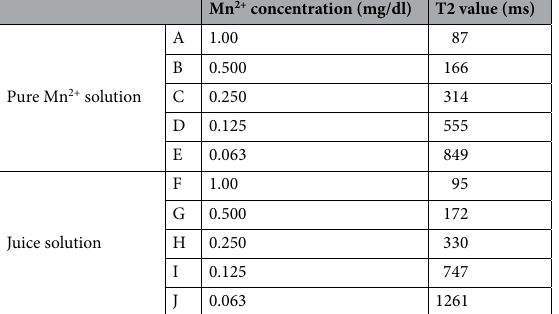
Table 1. The impact on the T2 values of the five different solutions of PJ was practically the same as the five differ- ent chemical dilutions of the pure Mn 2+ solutions and, therefore, the best suppression of the GD liquid signal was obtained with a Mn 2+ concentration ranging from 0.5 to 1.0 mg/dl within the stomach and duodenum (Table 1). For the clinical validation, the Authors relied on the results of the in vitro measurements: (a) 150 ml (1 full glass) of PJ contain 2.37 mg/dl of Mn 2+ and (b) the best suppression of the GD liquid signal was obtained with a Mn 2+ concentration ranging from 0.5 to 1.0 mg/dl. Assuming that the total GD fasting content does not exceed